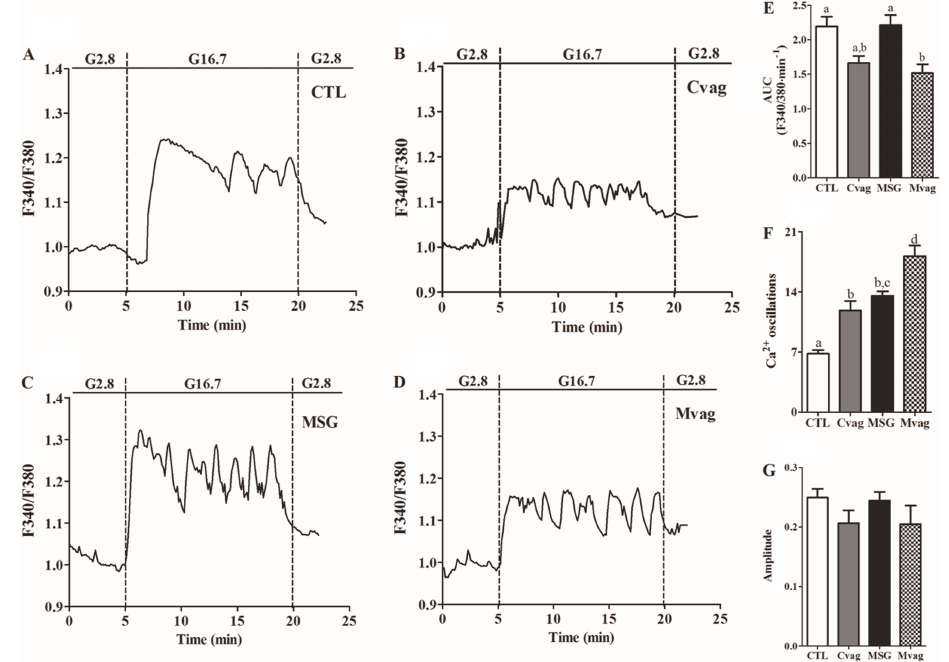
Figure 5. Representative curves of carbachol (Cch) (100 m M) induced internal Ca 2++ mobiliza- tion in islets isolated from 90-day-old CTL ( A ), Cvag ( B ), MSG ( C ) and Mvag ( D ) rats. E , AUC and F , amplitude of the [Ca 2++ ]i in response to Cch. The experiments were performed in a perifusion system in a Ca 2++ -free medium con- taining: 11.1 mM glucose (G11.1), 250 m M diaz- oxide, and 10 mM EGTA. Data are the ratio of F340/F380 registered for each group. CTL: control; Cvag: CTL with subdiaphragmatic vagot- omy; MSG: monosodium glutamate; Mvag: MSG with subdiaphragmatic vagotomy. Data are reported as means±SE obtained from 6-10 independent perifusion experiments. Different letters indicate statistically significant differences (two-way ANOVA followed by Duncan’s post- test, P #